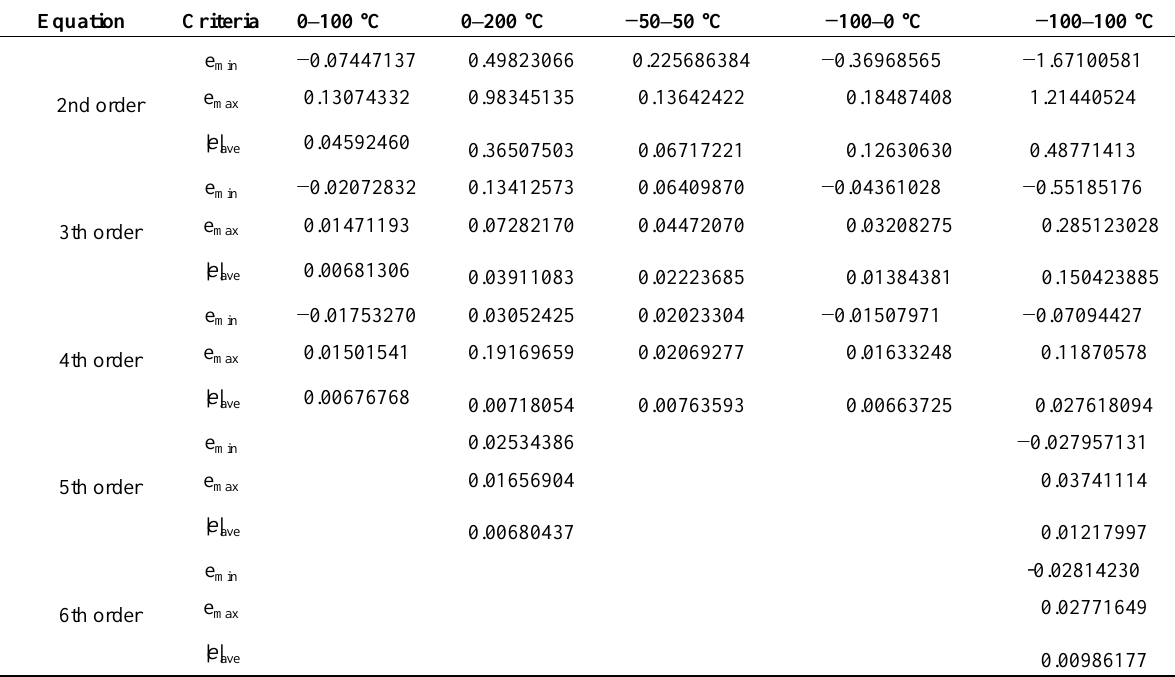
Table 2. Criteria for evaluating of polynomial equations for T-type thermocouples by temperature range. Sacle equation to same font size as